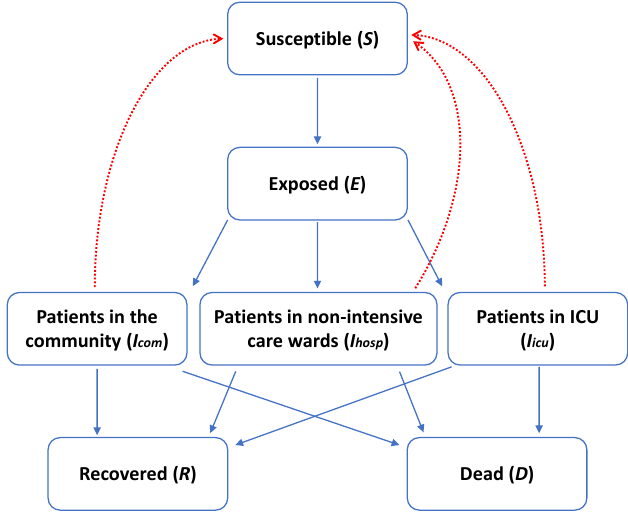
Figure 1. The employed Susceptible-Exposed-Infectious-Recovered-Dead (SEIRD) epidemic model for novel coronavirus (SARS-CoV-2) epidemic in Sicily, Italy. This diagram summarizes the flow of individuals across SEIRD compartments (blue lines); red dotted lines, instead, represent the potential transmission of SARS-CoV-2 from infectious to susceptible individuals.